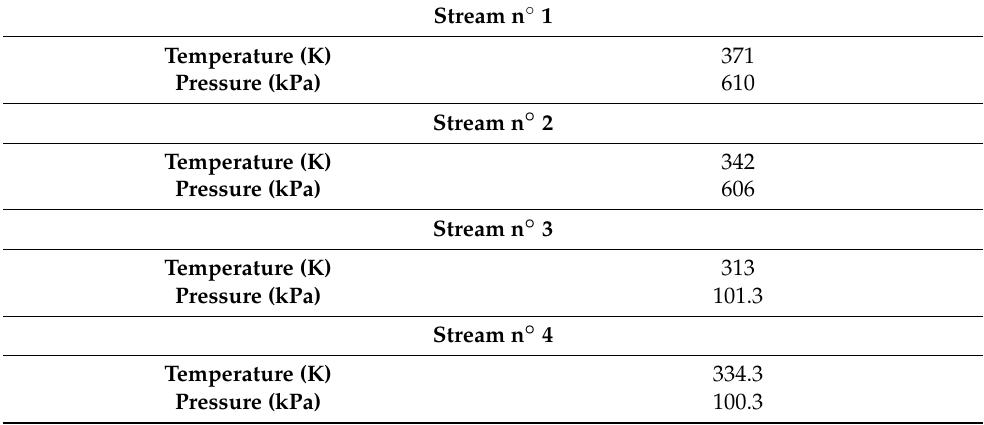
Table 3. The condenser’s main dimensions.